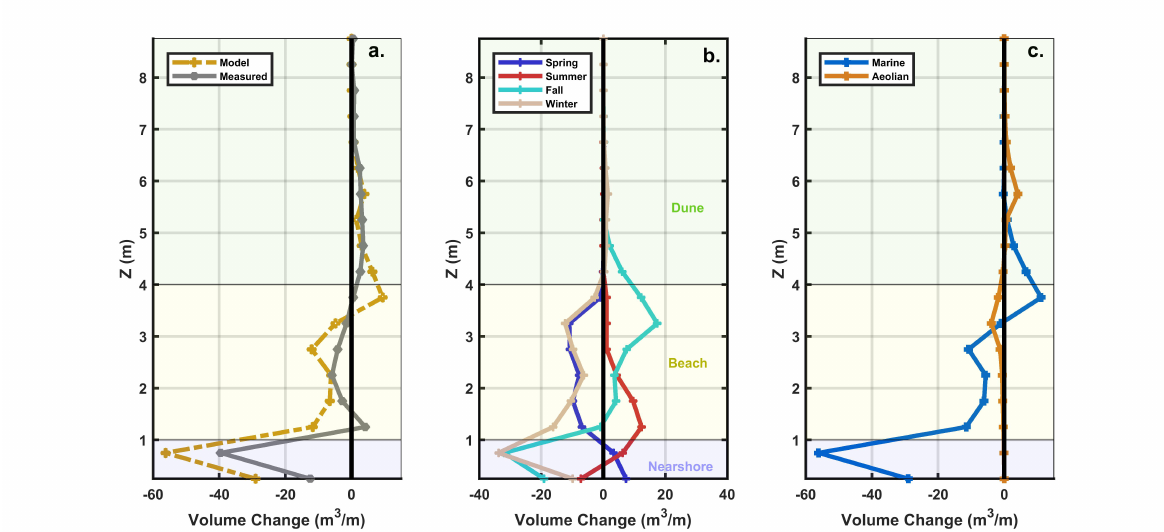
Figure 7. ( a ) Comparison of volume changes (binned vertically in 0.5 m increments) between the field measurements (dashed grey line) and model predictions (dashed yellow line) at annual scale for the calibrated simulation. ( b ) Windsurf output with vertically binned volume changes broken down by the seasonal cycles of deposition. ( c ) Windsurf simulated volume changes are distinguished between marine (solid blue line) and aeolian (solid orange line) contributions. Please note that the x -axis limits change on each panel.